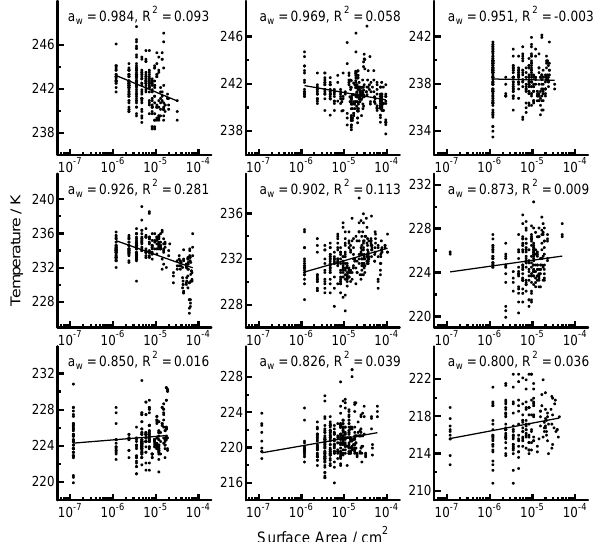
Fig. 6. Heterogeneous freezing temperatures of aqueous NaCl/diatom droplets shown as dots are plotted as a function of diatom surface area for each investigated water activity. The solid lines represent best fits to the data. The coefficient of determination, R 2 , indicates the quality of the corresponding